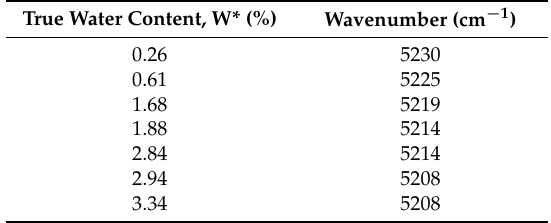
Figure 3. Difference of spectra with respect to the dried epoxy of the water absorbance band in epoxy resin samples of varying water content. The baseline corresponds to the driest sample (in this case, dried). Table 1. True water content and the corresponding wavenumber values at the absorption